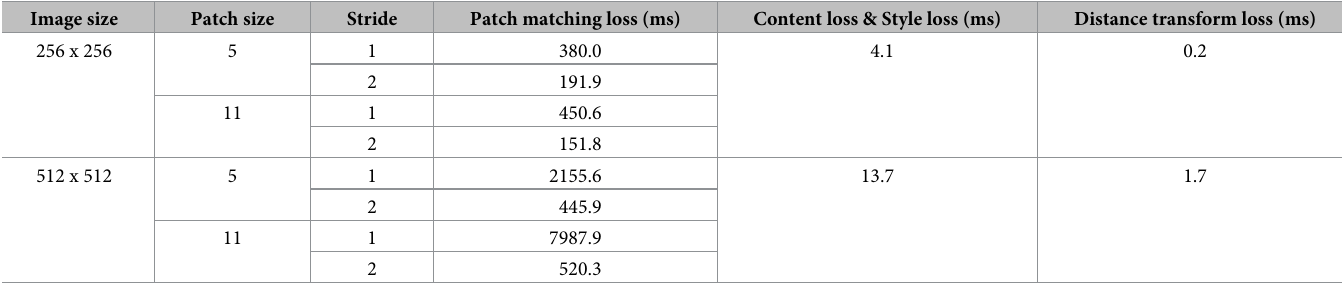
Table 1. The average computation time of each loss in one iteration. Image size Patch